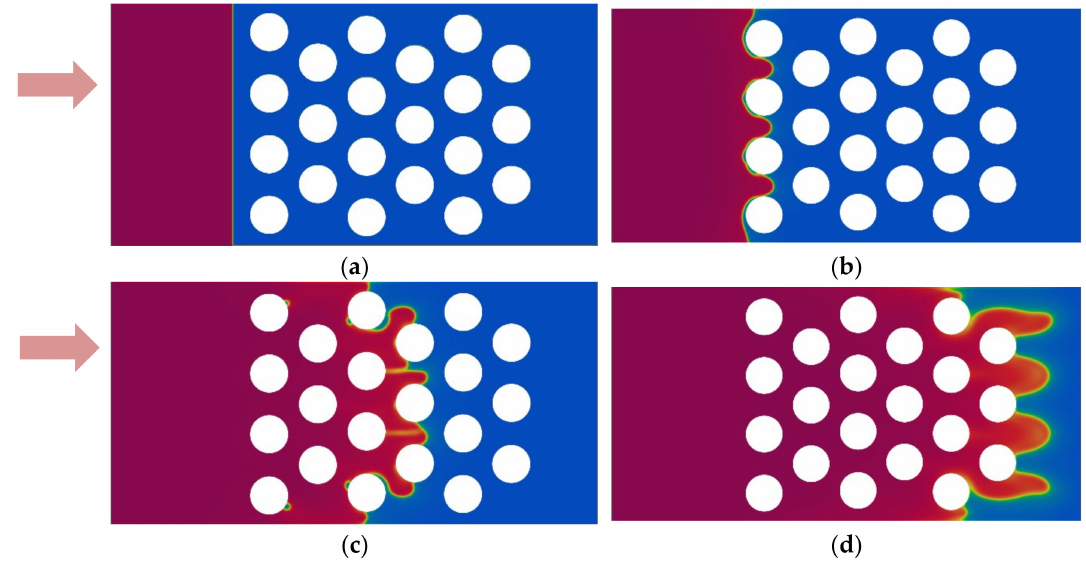
Figure 10. CO 2 penetration pattern with a flat front profile initially at 7 LU from pore network. The same color scheme is used, as in Figure 6. ( a ) 0 ts. ( b ) 1600 ts. ( c ) 4800 ts. ( d ) 7100